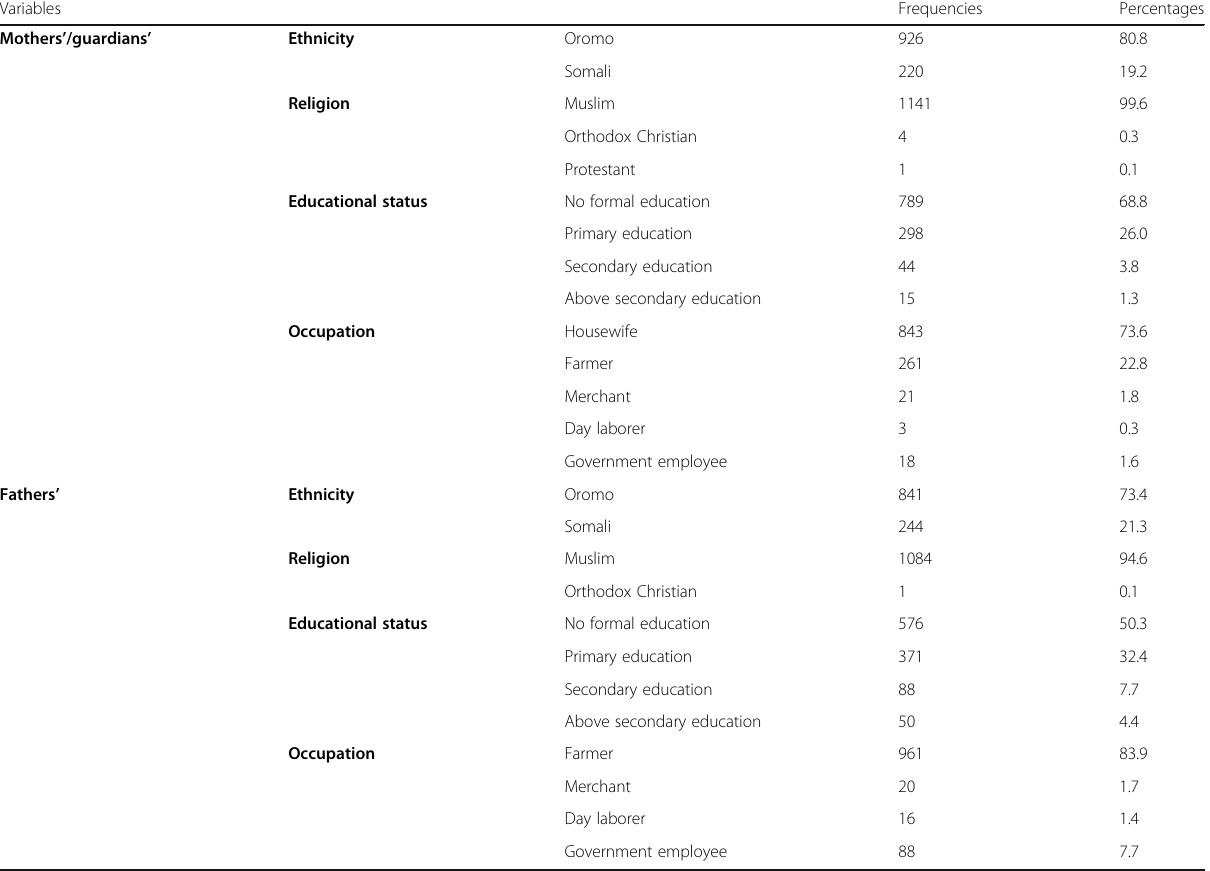
Table 1 Socio-demographic characteristics of the parents of the under-five children, rural areas of Dire Dawa City Administration, 2018 Variables Mothers ’ /guardians